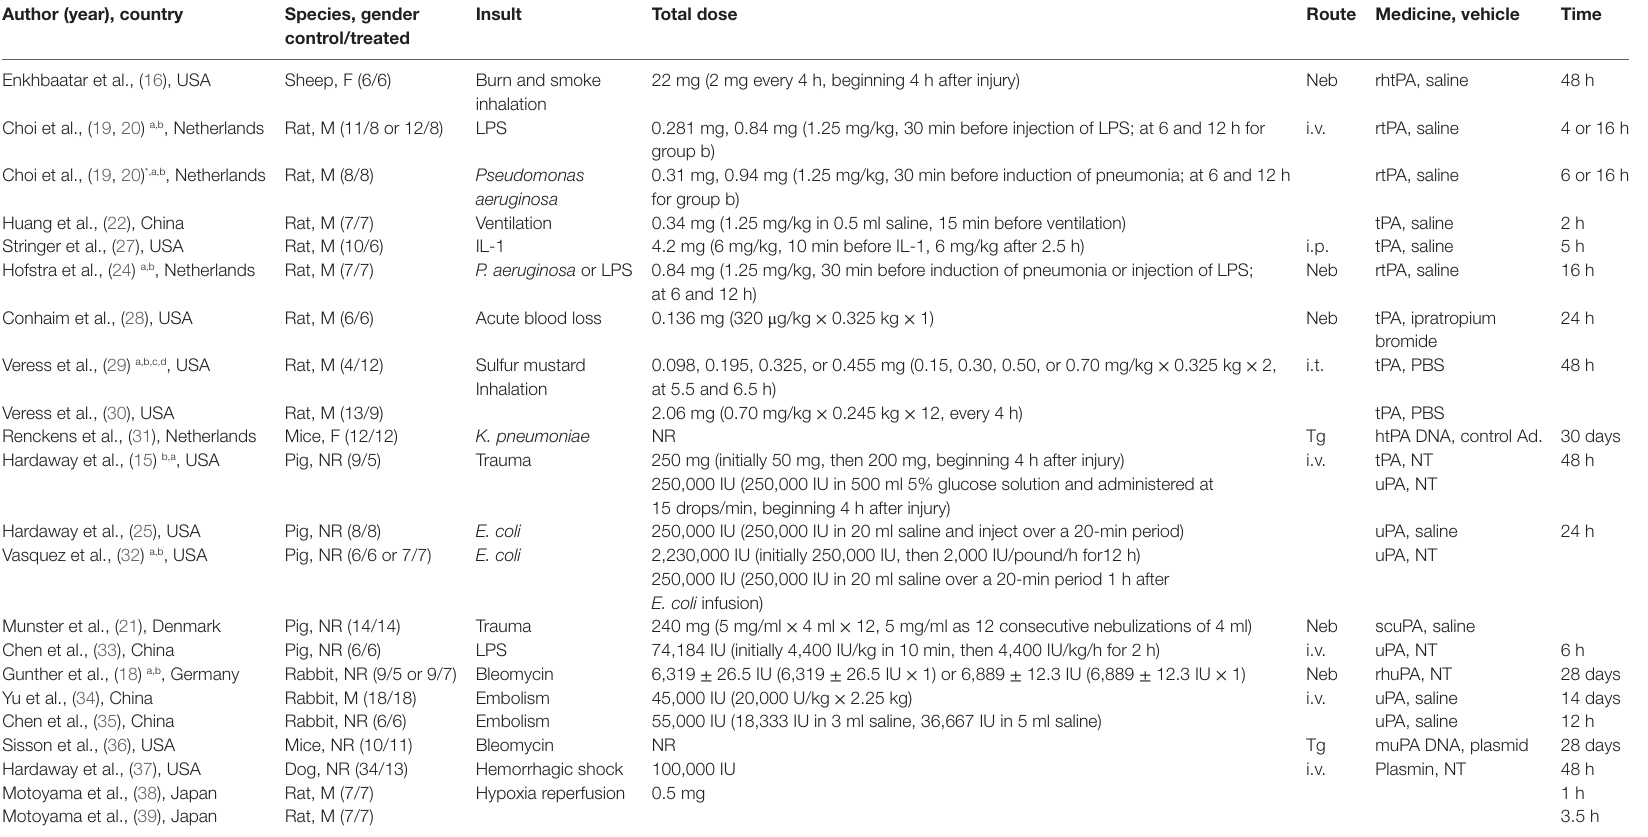
taBLe 1 | General characteristics of included